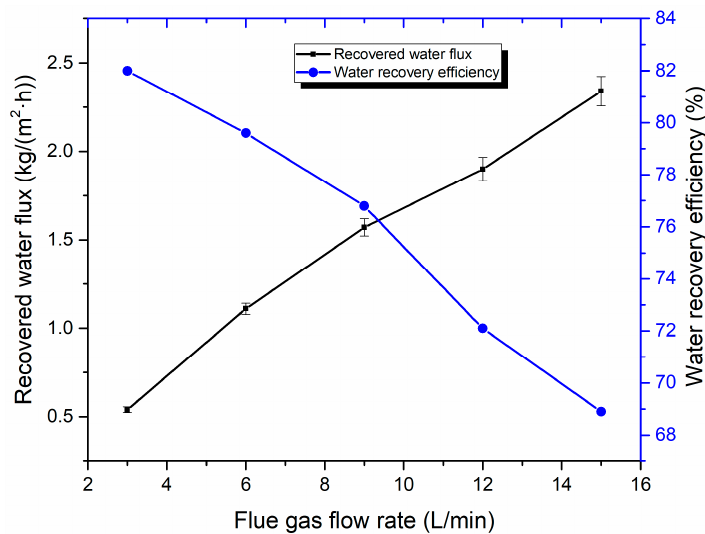
Figure 12. Effect of flue gas flow rate on water recovery performance (Experiment conditions: flue gas temperature 50 °C, cooling water flow rate of 1 L/min, cooling water temperature of 20 °C).